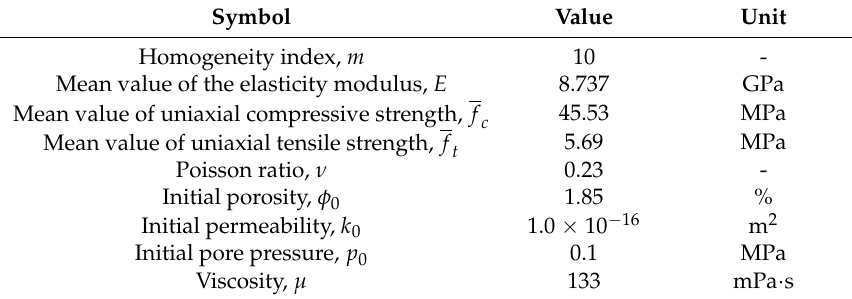
Table 2. Input parameters for the near-wellbore hydraulic fracturing model.